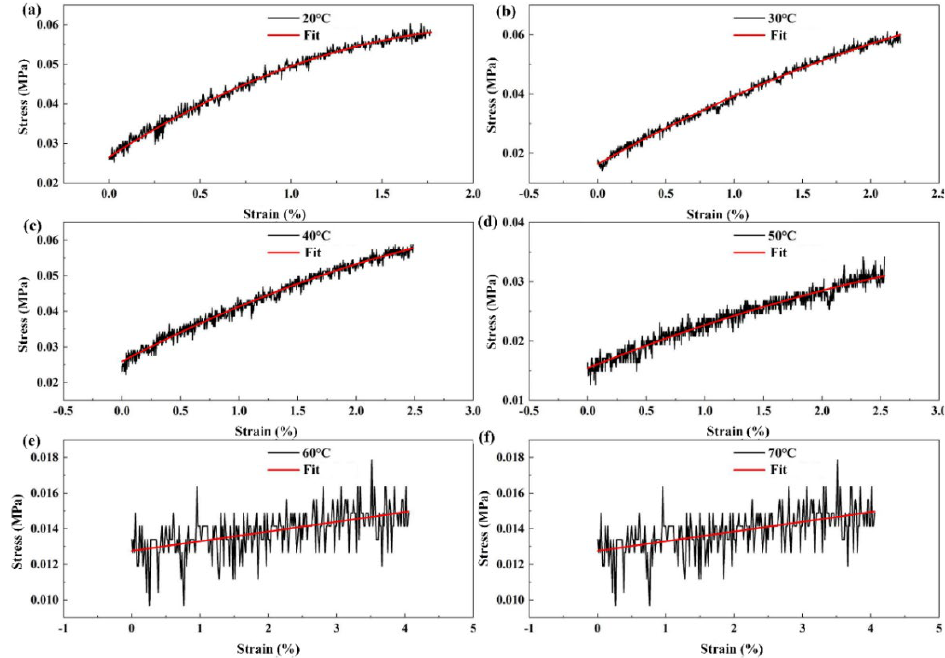
Figure 3. Stiffness variation of a single TPU sample with increasing temperature. ( a ) to ( f ) show stress–strain curves at 20°C, 30°C, 40°C, 50°C, 60°C and 70°C, respectively. The fitting curves indicate the nearly linear relationship between stresses and strains of in the TPU sample at different temperatures.